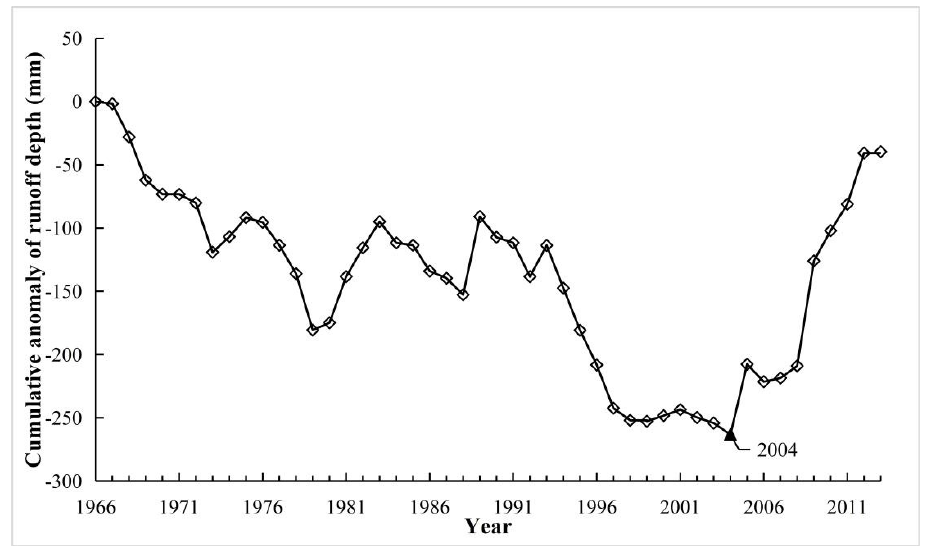
Figure 5. Cumulative anomaly curve (CAC) of annual runoff depth from 1966 to 2013 in the YRHA.